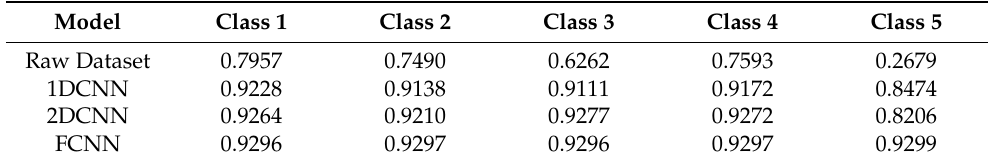
Table 3. Comprehensive performance evaluation results.